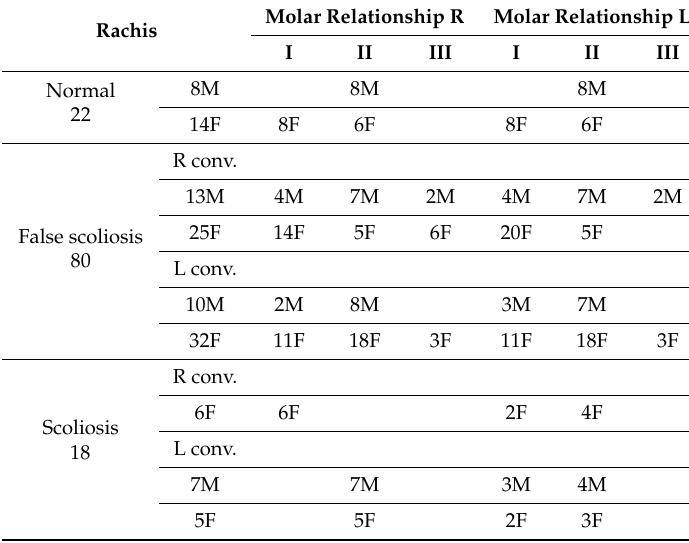
Table 3. Relations between scoliosis and molar relationship (according to Angle’s classification) in our sample. Molar Relationship R Rachis